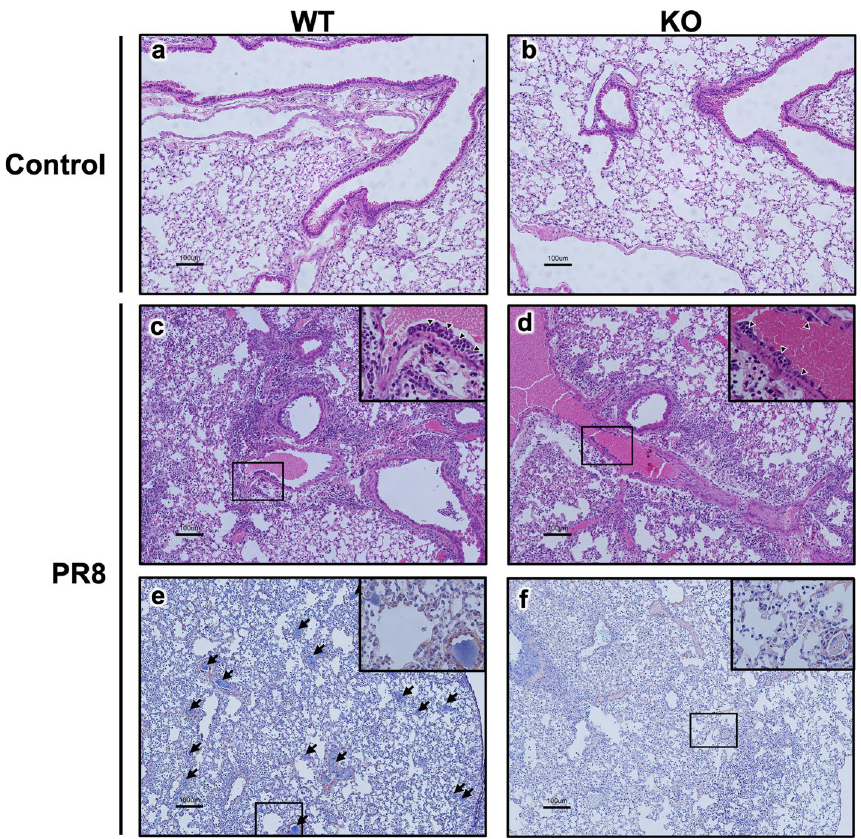
Figure 6. Effect of OLR1 on virus infection-induced inflammation and intravascular thrombosis in the lungs. WT and KO mice were intranasally inoculated with PBS alone or PBS comprising the PR8 virus. Lung samples were collected at 6 dpi, fixed in 4% paraformaldehyde, embedded in paraffin, and cut in 5 μm. For histopathological analyses, sections were stained with ( a–d ) HE or ( e and f ) PTAH. ( a ) WT control, ( b ) KO control, ( c and e ) WT infected with PR8 virus, and ( d and f ) KO infected with PR8 virus. Scale bars, 100 μm. ( c and d ) Arrowheads in inserts indicate the leukocytes in the vascular intima. ( e and f ) Arrows